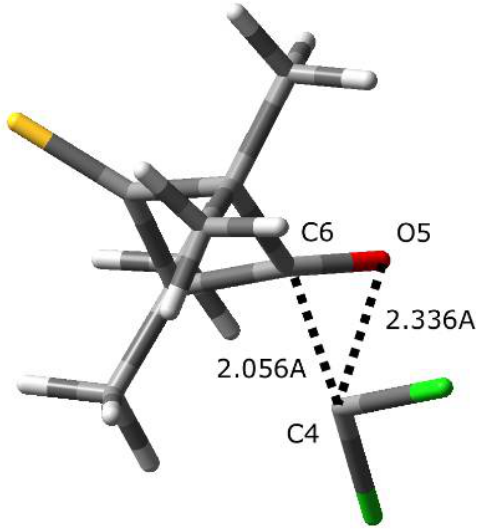
Figure 7. Views of the TS structure for 1 a + 2b → 10ab transformation in the reaction starting with